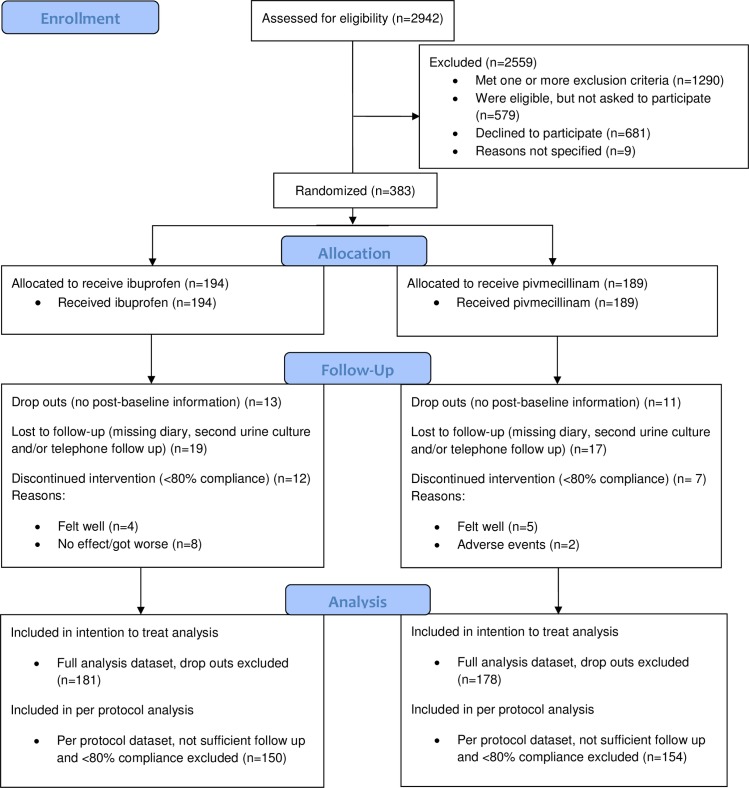
Flow of participants through trial of ibuprofen versus pivmecillinam for women with uncomplicated urinary tract infection.